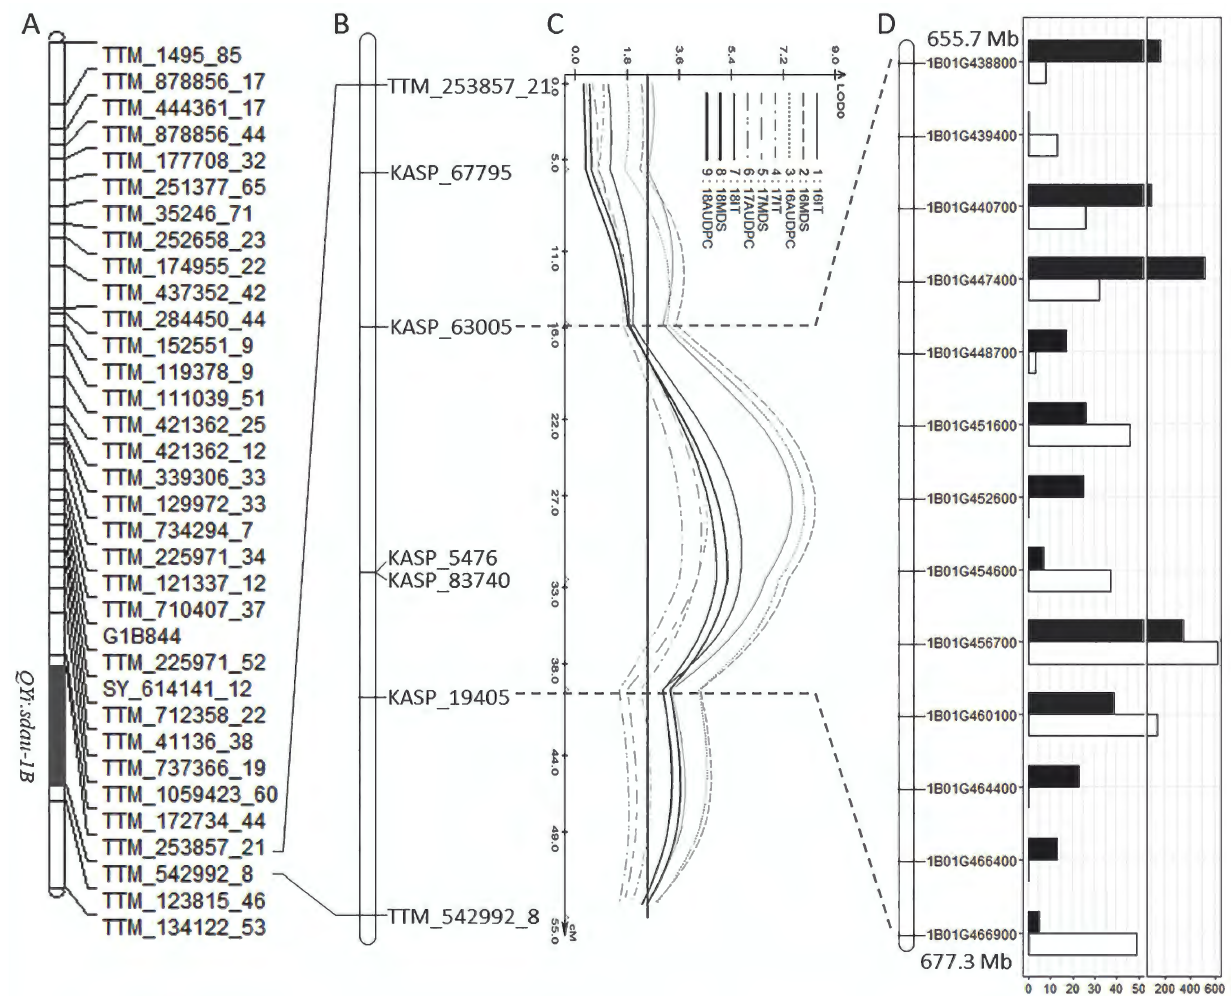
Figure 6. A physical map of QYr.sdau-1B . ( A ) The position of QYr.sdau-1B in a genetic mapping. ( B ) Five KASP markers developed based on the SNPs in the QYr.sdau-1B region identified from RNA-seq. ( C ) Re-mapped location of QYr.sdau-1B after incorporation of the new KASP markers. ( D ) The expression profiles of 13 disease-resistance-related genes identified in the region of QYr.sdau- 1B from RNA-seq. The white and black bars indicated the relative expression levels of alleles from the susceptible parent Siyang 936 and resistant parent Tutoumai, respectively; the x -axis shows the FPKM value of the genes in the